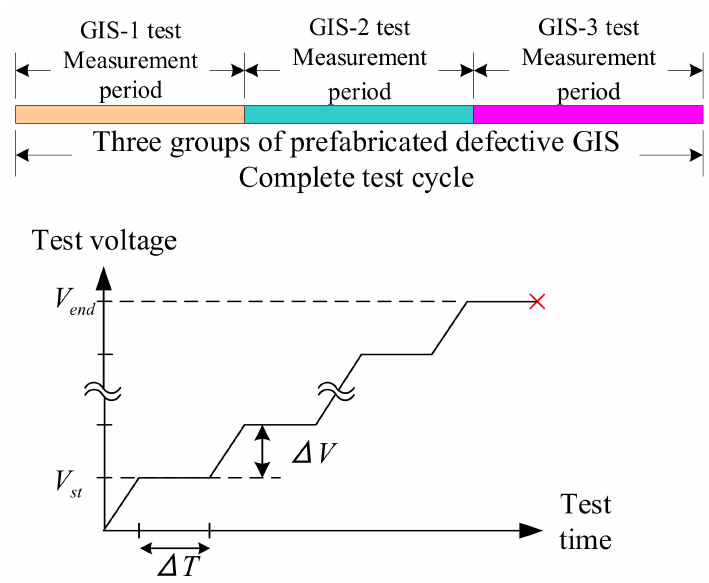
Figure 3. Experimental planning